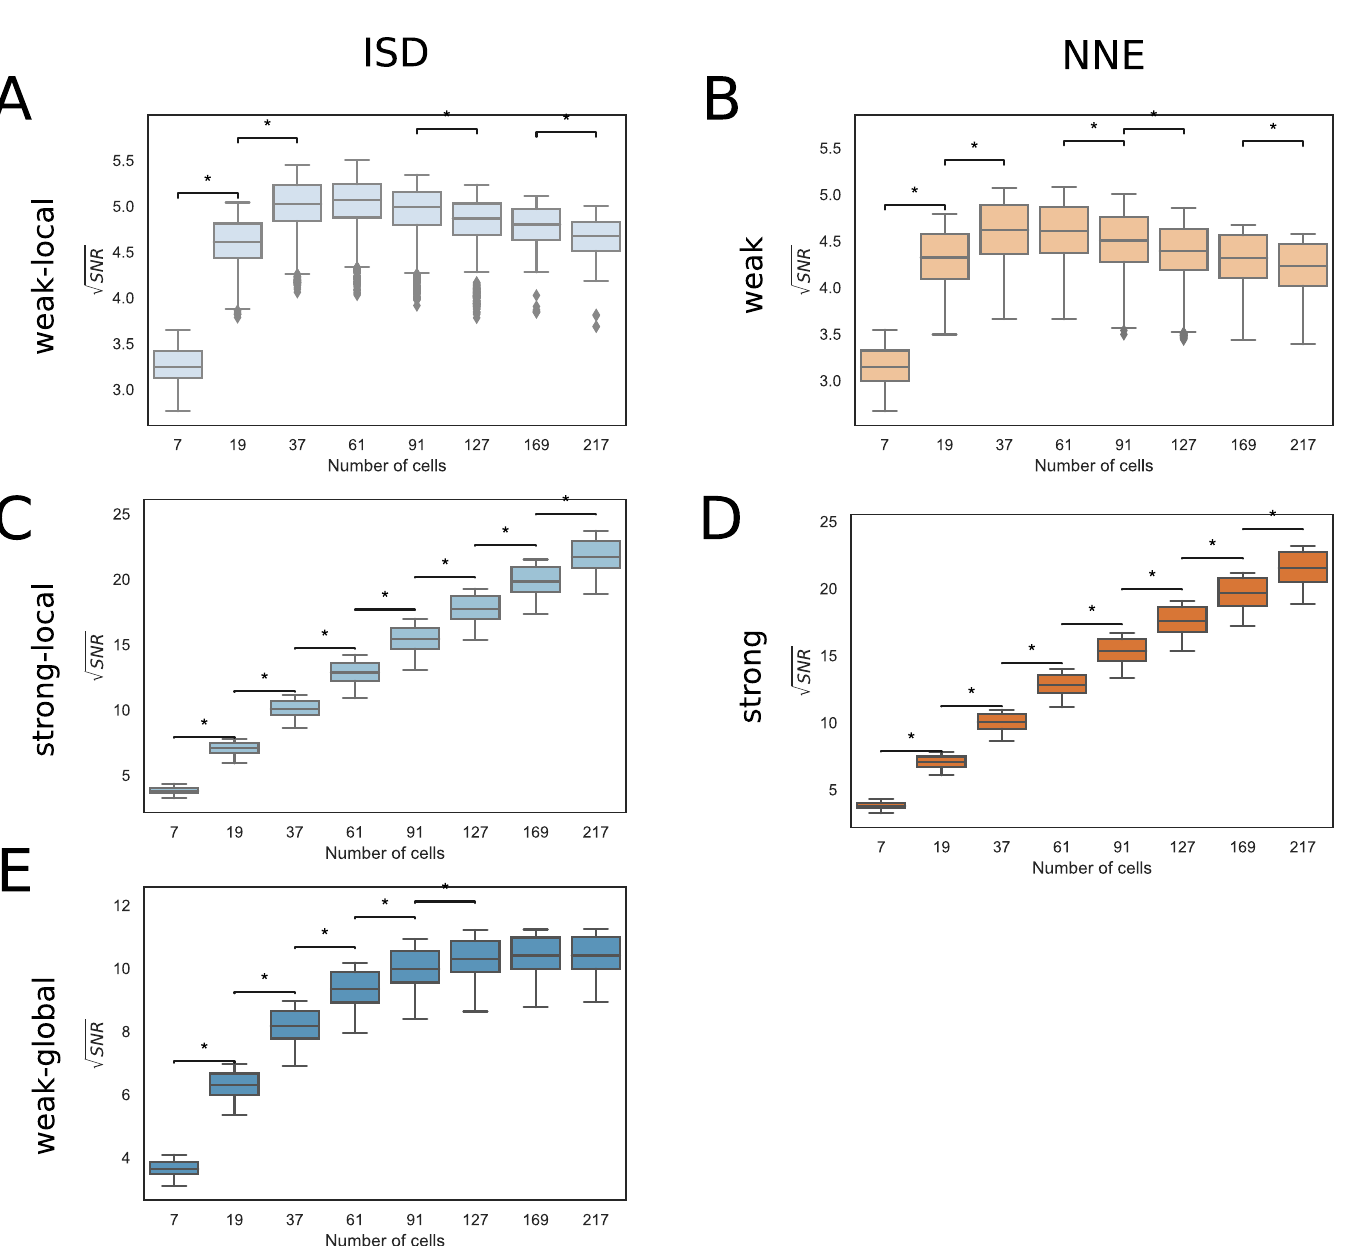
ffiffiffiffiffiffiffiffiffi p values for configurations with different number of cells and mean polygon SNR